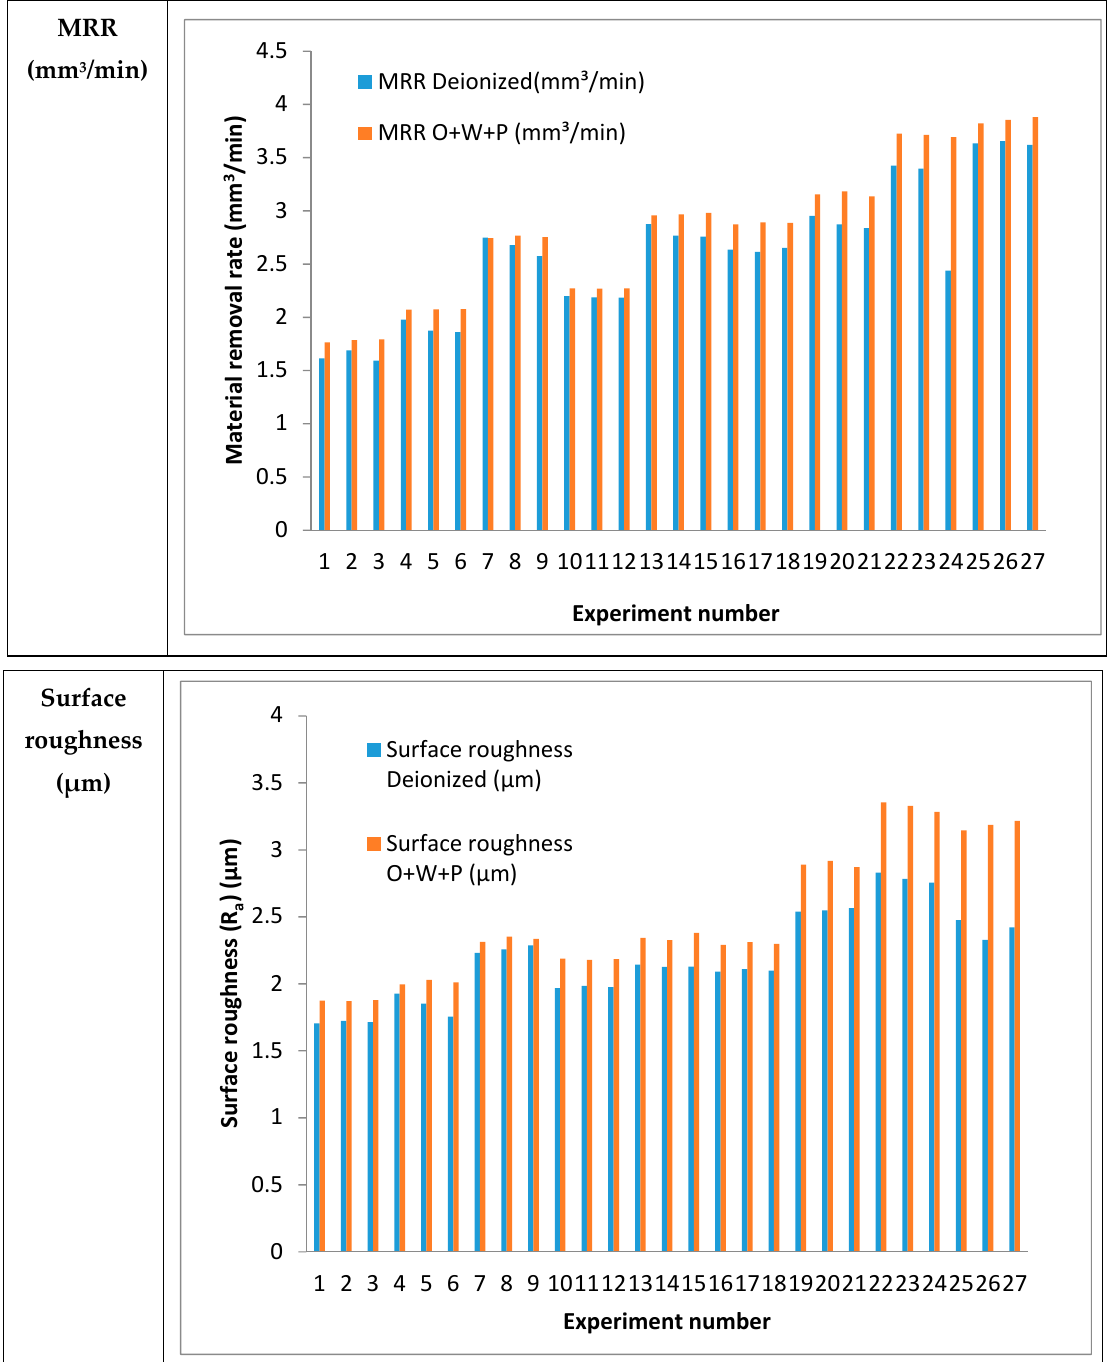
Figure 10. Graphical comparison between WEDM cutting of Al-SiC-TiC in deionized water and oil + wax + paraffin dielectric mediums.